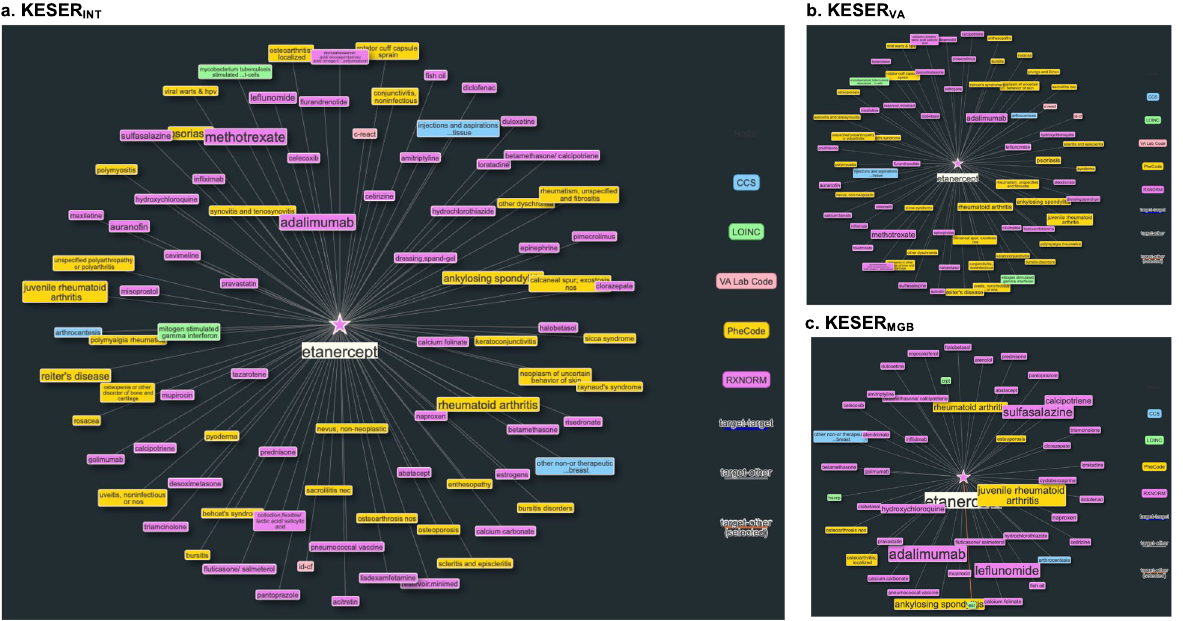
Fig. 4 Clinical knowledge network for Etanercept. ( a ) Knowlege network learned based on KESER INT ; ( b ) knowlege network learned based on KESER VA ; ( c ) knowledge network learned based on KESER MGB